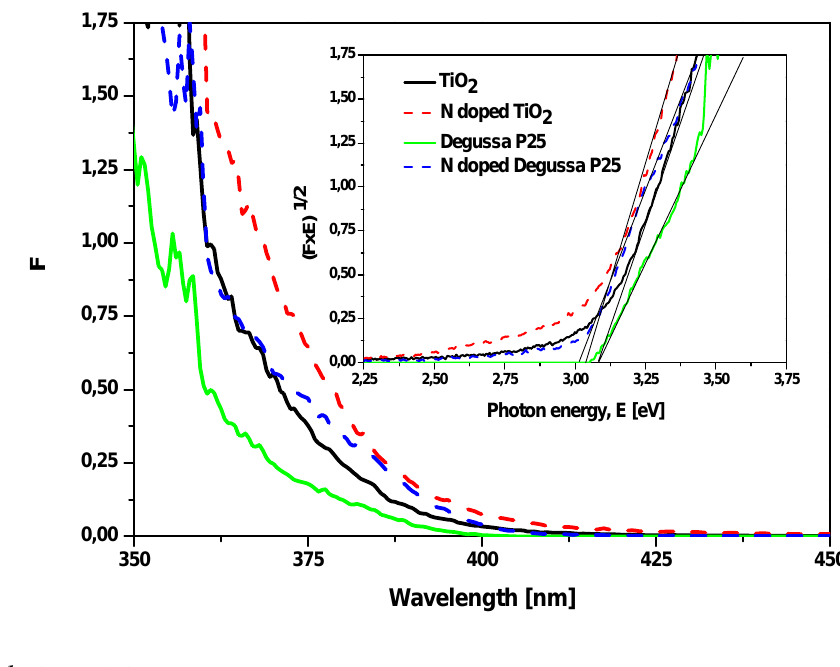
Figure 4. Kubelka-Munk absorption curves F for the powders studied. The band gaps appear in the inset as a result of the extrapolation